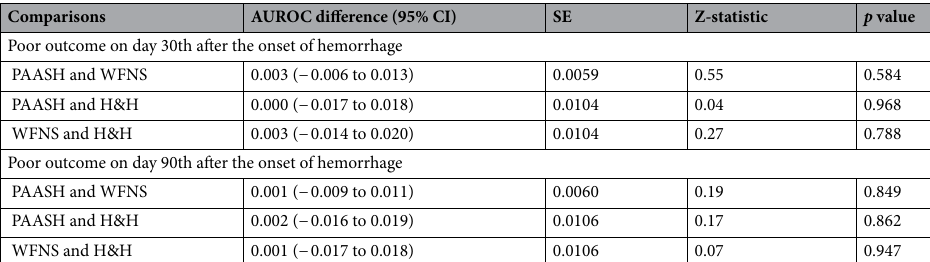
Table 2. Pairwise comparisons of AUROC of the PAASH, WFNS, and H&H scales for predicting the poor outcome (mRS of 4 to 6) after the onset of haemorrhage in patients with aneurysmal SAH. AUC the area under the curve, AUROC the area under the receiver operating characteristic, H&H Hunt and Hess scale, PAASH prognosis on admission of aneurysmal subarachnoid haemorrhage scale, SAH subarachnoid haemorrhage, SE standard error, WFNS World Federation of Neurosurgical Societies